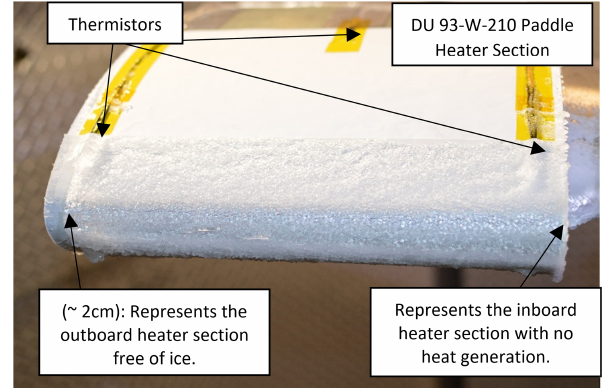
Figure 15. Schematic of representative inboard heater section with no heat.